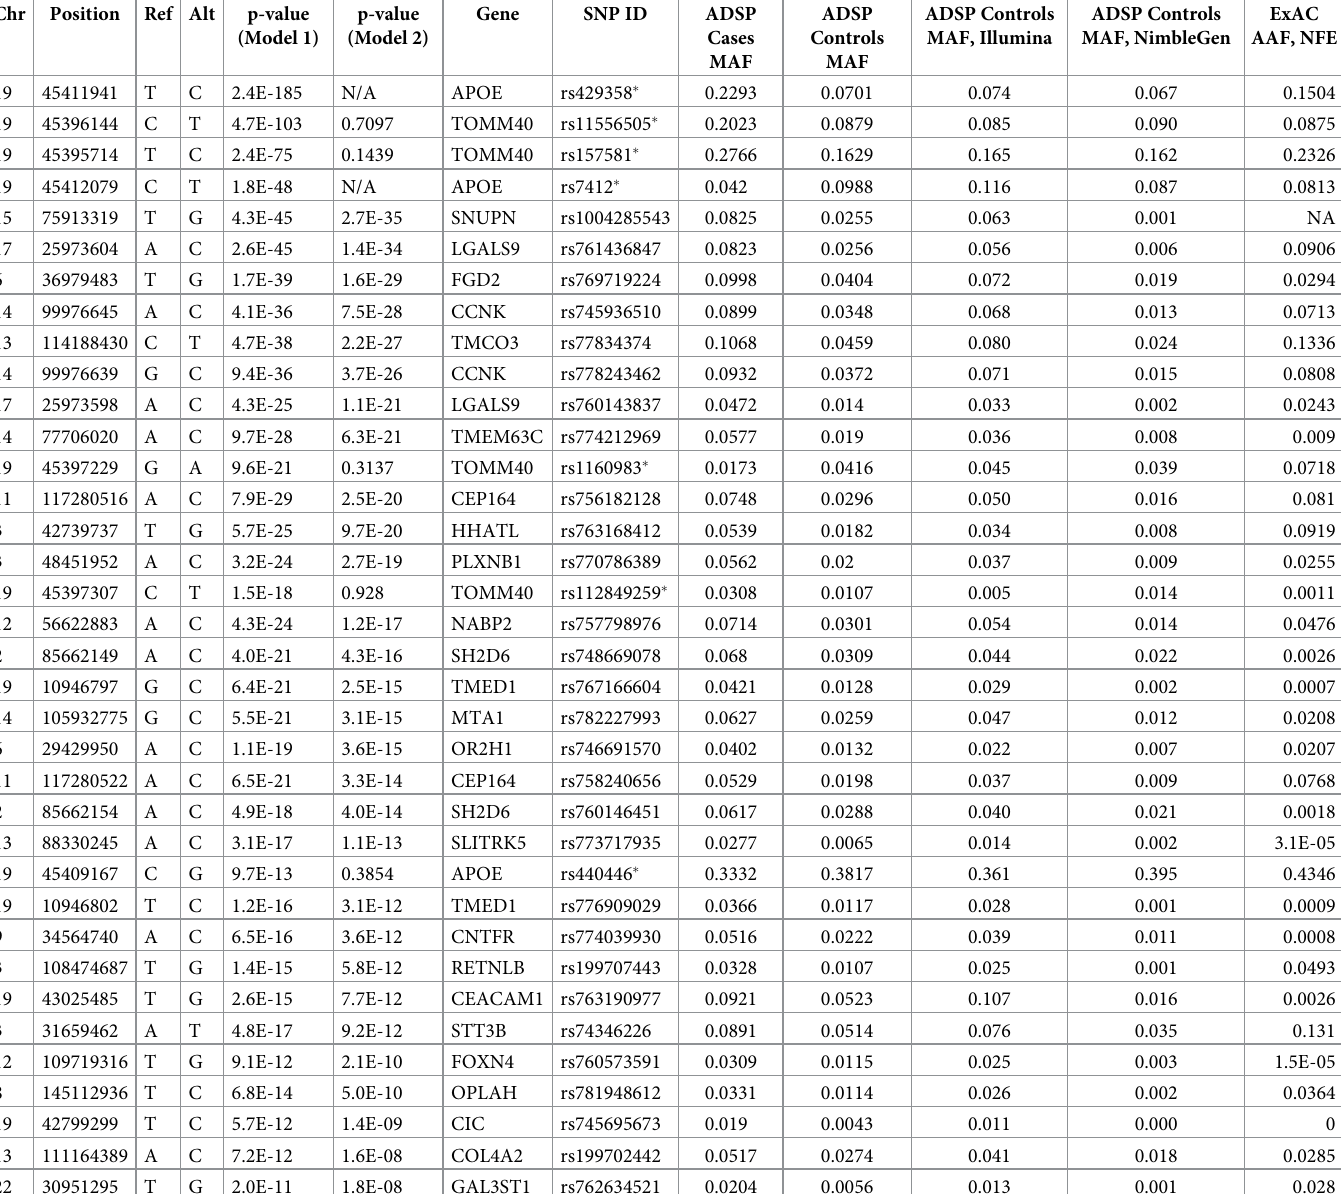
Table 1. Seven SNPs in APOE and TOMM40 (indicated by � of the SNP IDs) and 29 novel SNPs reaching exome-wide significance ( p < 3.0 x 10 − 7 , Bonferroni-cor- rected cutoff of p < 0.05 / # tests): Population minor allele frequency (MAF) in cases and controls, MAF in controls processed by Illumina or NimbleGen exome cap- ture kit, and MAF in Non-Finish European (NFE) cohort of the ExAC database